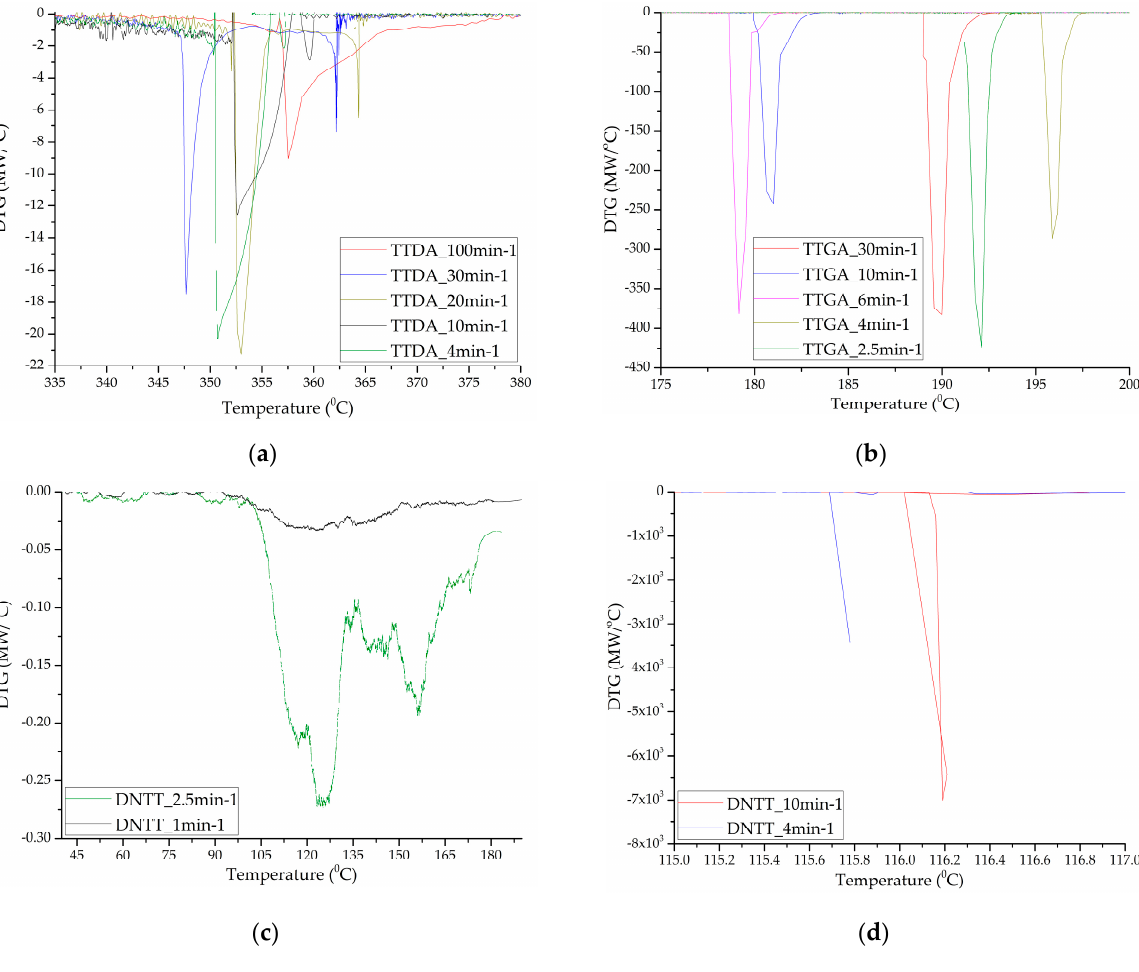
Figure 6. Differential decomposition curves of samples TTDA ( a ); TTGA ( b ) and DNTT ( c , d ).